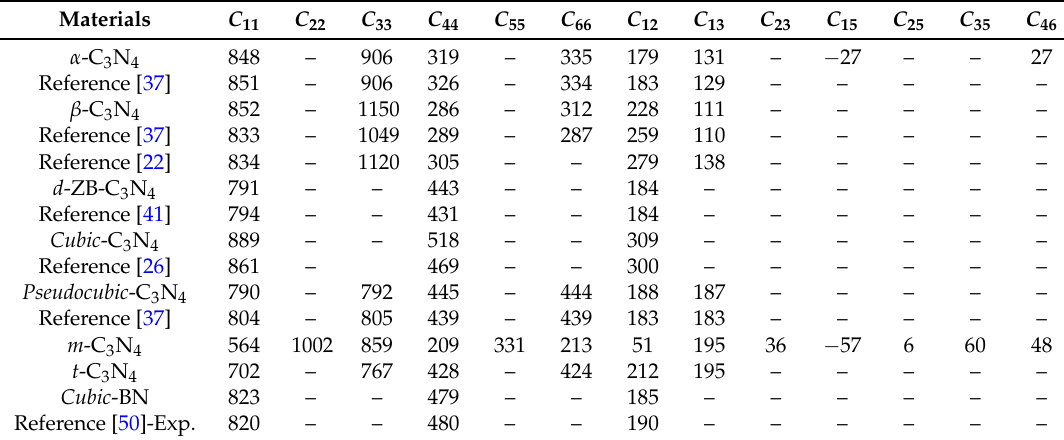
The calculated elastic constants (GPa) of m -C 3 N 4 , t -C 3 N 4 , d -ZB-C 3 N 4 , cubic -C 3 N 4 , pseudocubic -C 3 N 4 and cubic -BN.